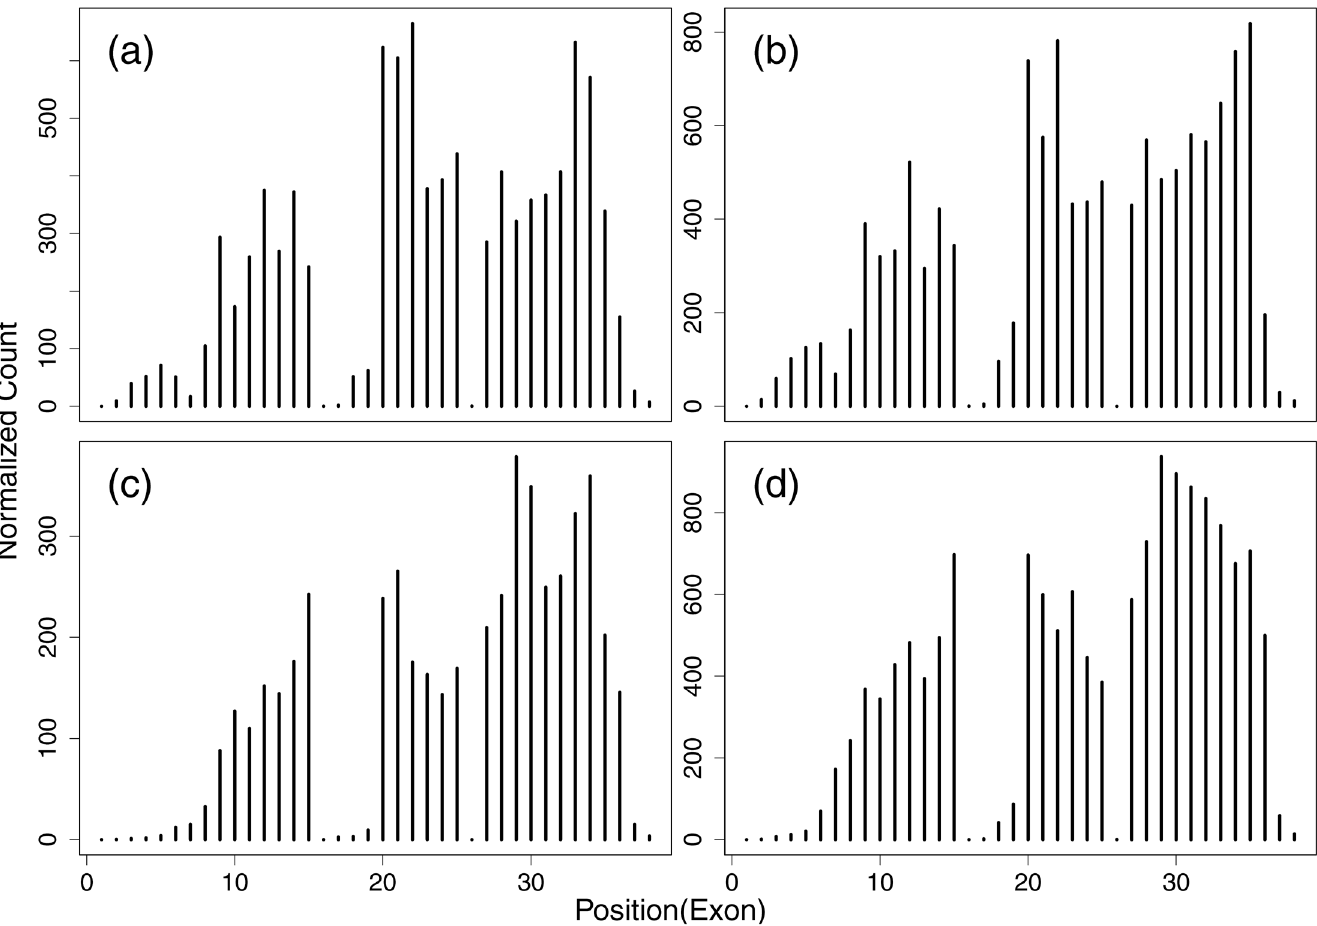
Fig 2. Normalized read counts for each exon along gene ENSG00000197746 (PSAP) in different tissues of the Human Body Map dataset (a) brain, (b) breast, (c) liver and (d) lung. Reads mapped to each exon are counted and normalized according to the exon length. Overlapping exons are segmented into multiple non-overlapping